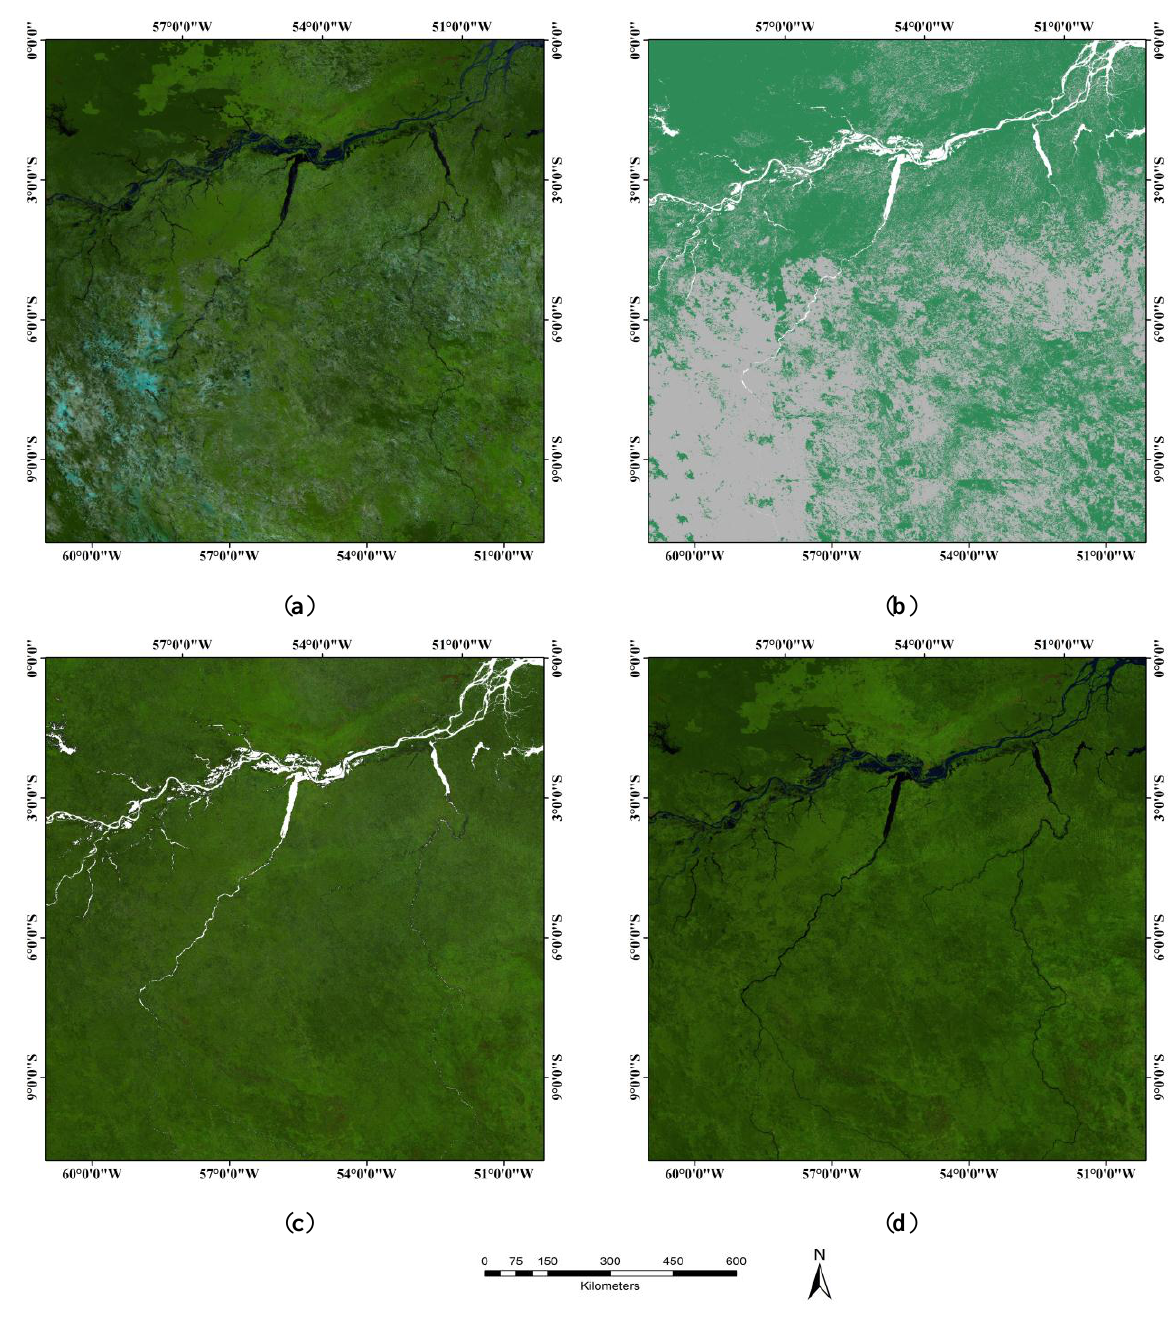
Figure 3. Tile h12v09 for day 97, 2003. ( a ) RGB image for surface reflectance from MOD09A1; ( b ) cloud (grey) mask from the VIRR algorithm; ( c ) RGB image for reconstructed surface reflectance from the VIRR algorithm; ( d ) RGB image for reconstructed surface reflectance from the TSCD algorithm. The RGB images were produced with an RGB color scheme that employs bands B6 (as red color), B2 (as green color), and B1 (as blue color), and the same color enhancement was